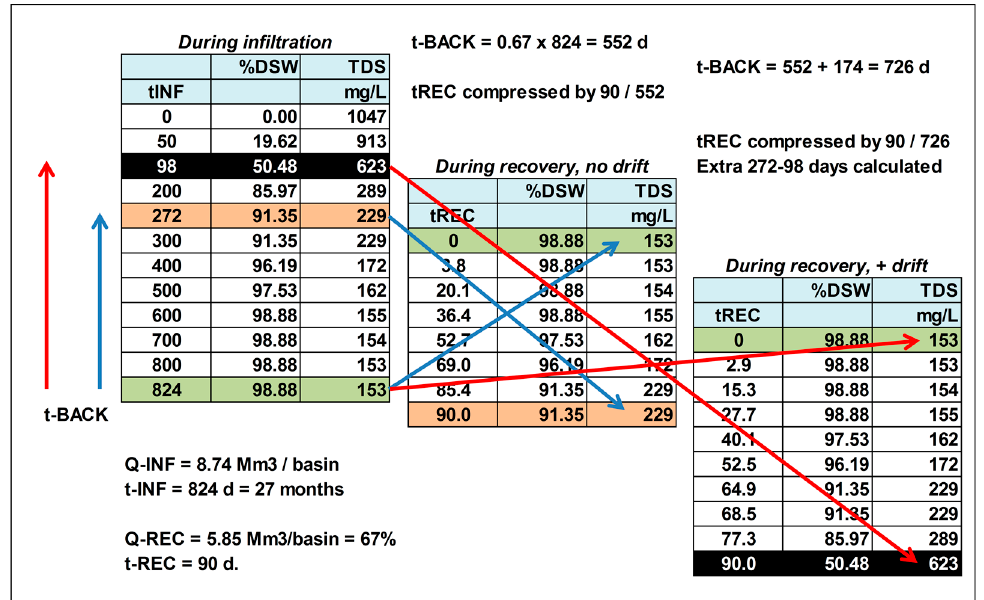
Figure 7. Explanation to how the predicted “fictive” mixed water quality at the recovery wells during 824 d of infiltration is used in backward mode, for predicting water quality during 90 d of recovery, without or with bubble drift effects. The forward EL prediction is reversed and its time axis compressed.